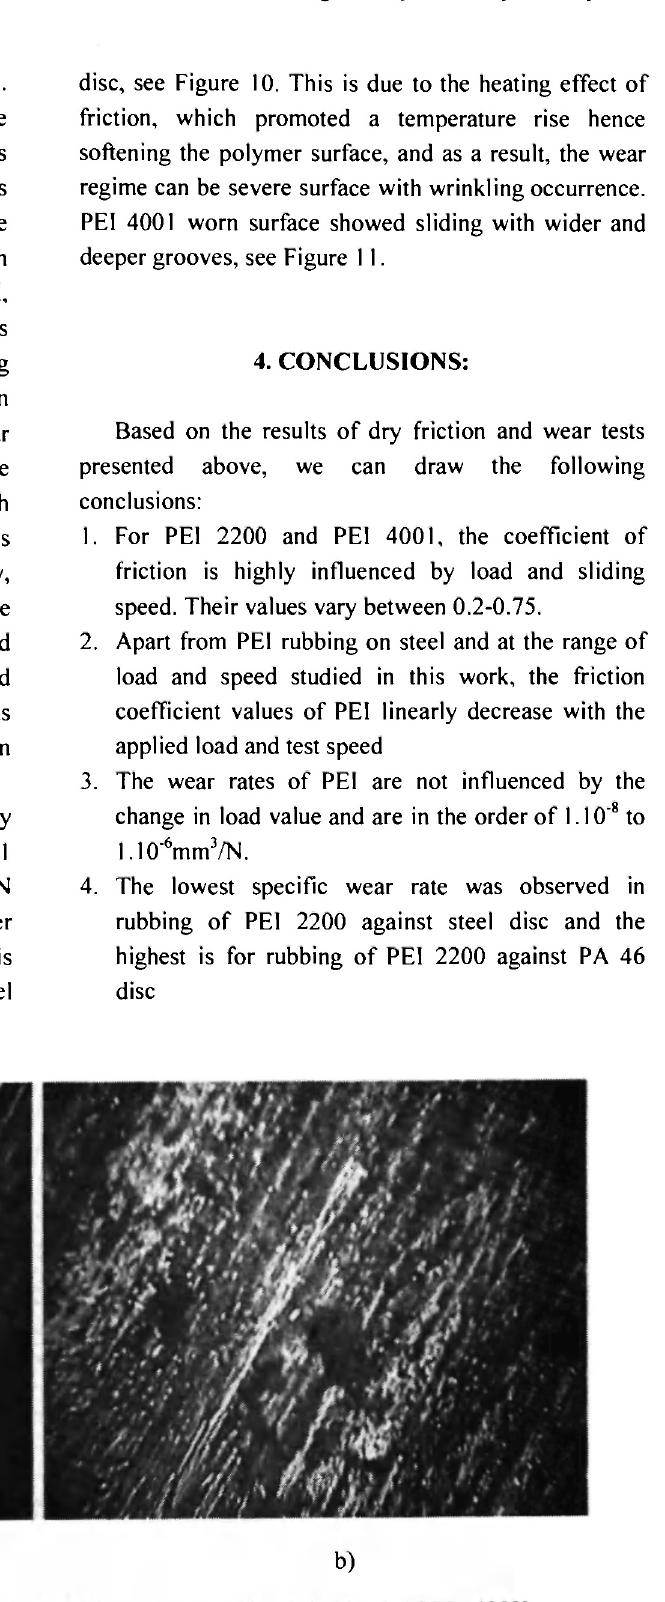
Fig. 10: Microscopy of worn surfaces of a) PEI 2200 polymer against PA 46+30%GFR, 400X b) PEI 2200 against AISI D2 steel, 400X, at 40N load and 1 m/sec. sliding